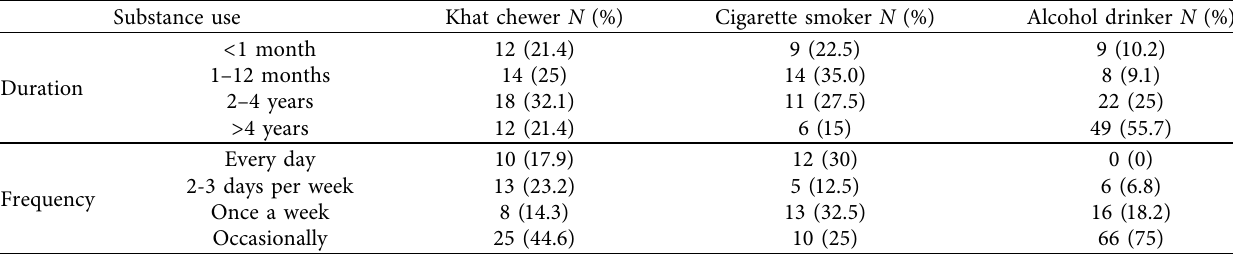
Table 4: Distribution of behavioral factors/substance use among study participants in relation to gender, N � 260, AU, January